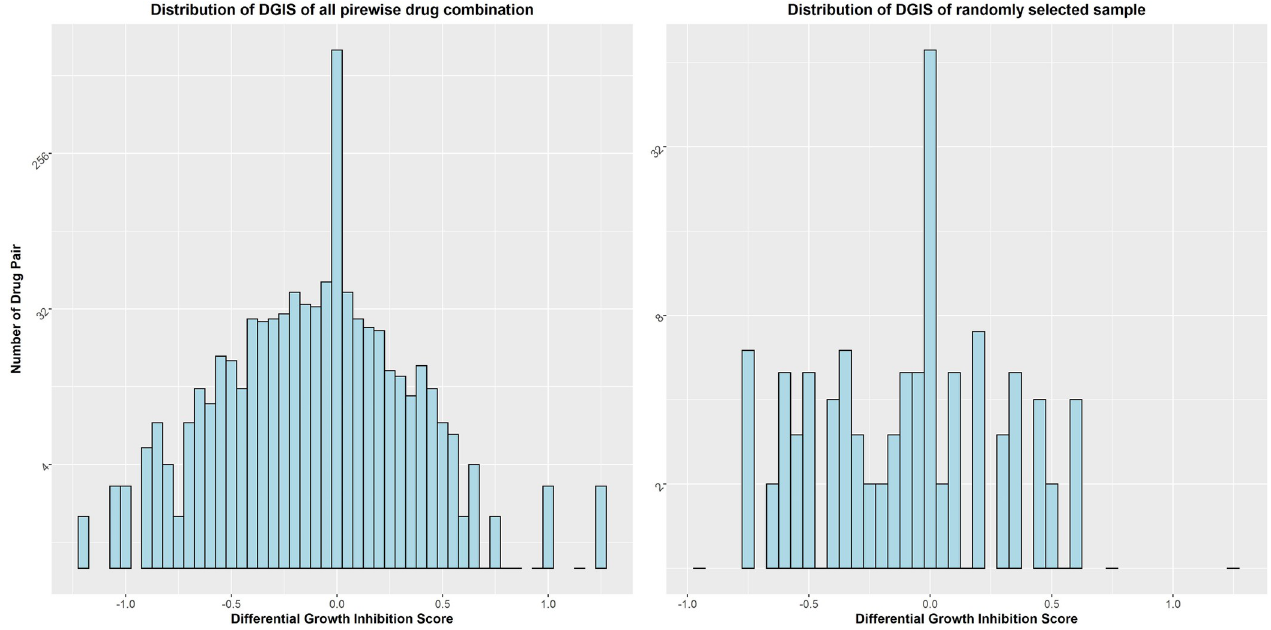
Fig 9. Distribution of DGIS for all pair wise drug